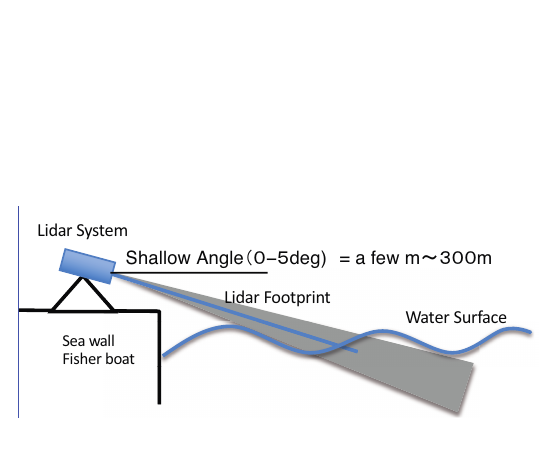
Fig.3 Shallow angle observation with LED Raman lidar.